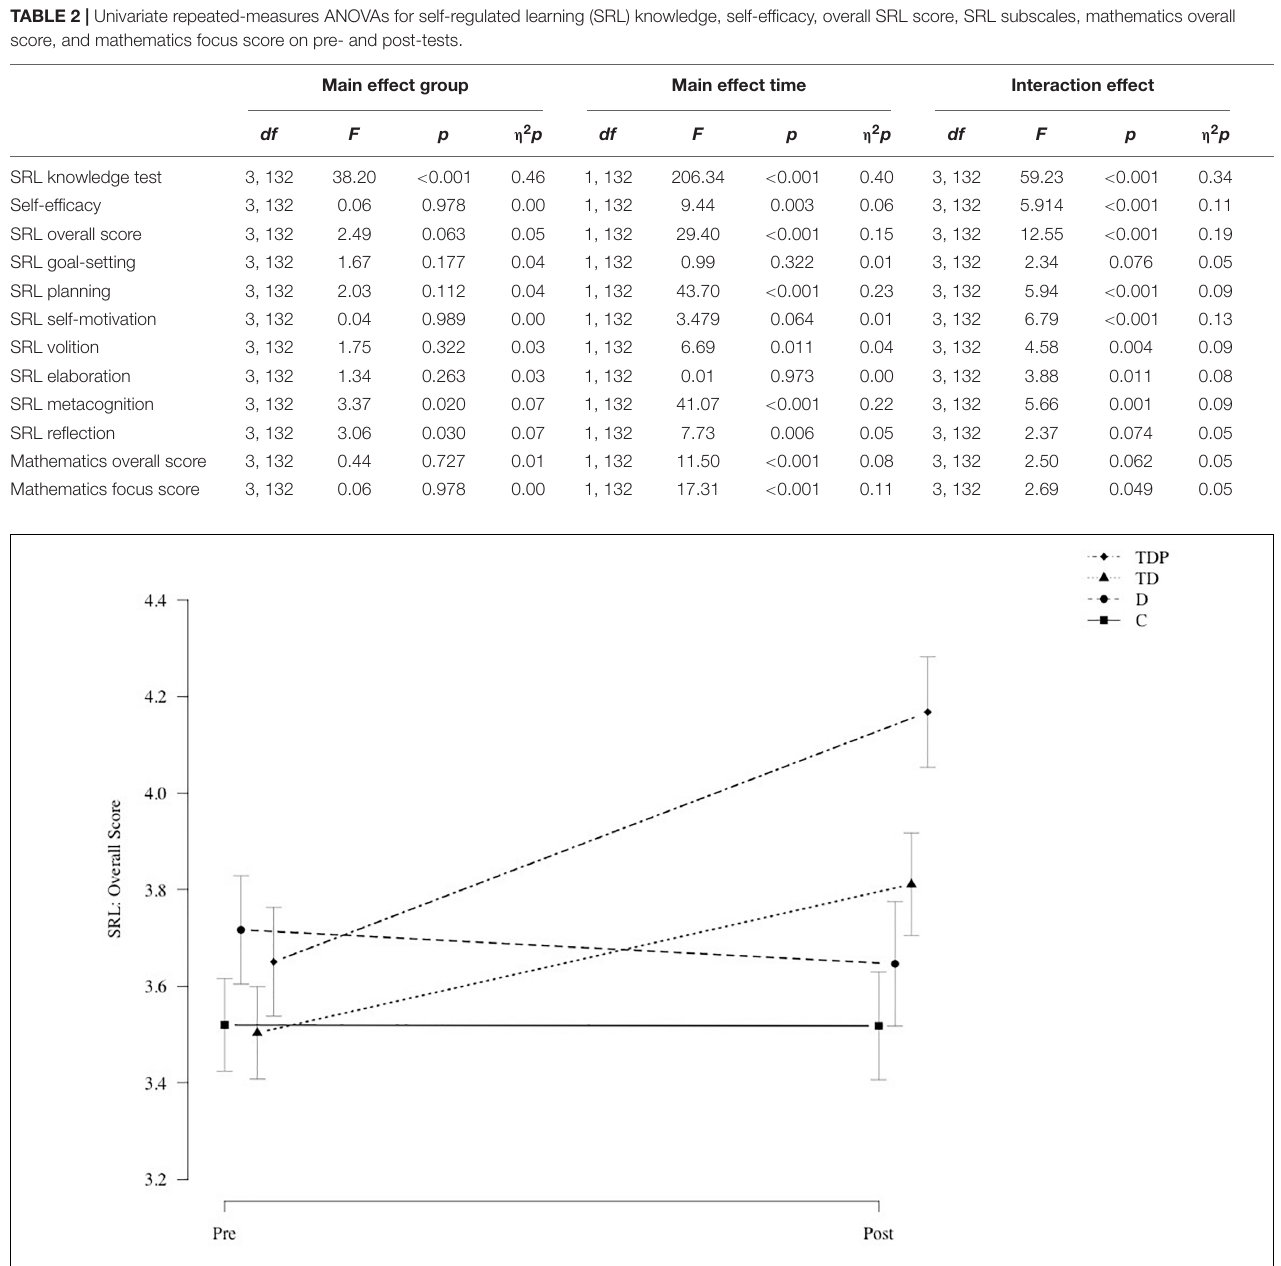
FIGURE 1 | Self-regulated learning (SRL) overall scores on pre- and post-tests for Groups C (control group), D (diary), TD (training + diary), and TDP (training + diary + peer feedback